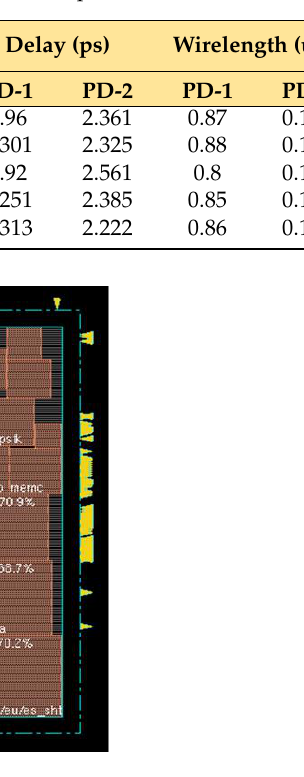
Figure 3. Layout: After implementation of proposed early clock floorplanning in AES_CORE.